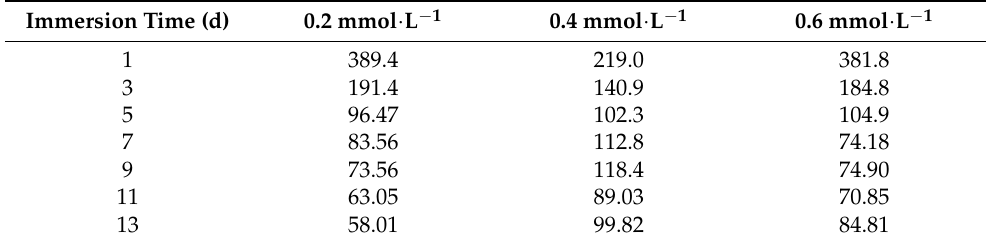
Table 4. R ct values obtained by EIS fitting of magnesium alloy AZ31B immersed in 3.5% NaCl solu- tion with different concentrations of PO 43 − .